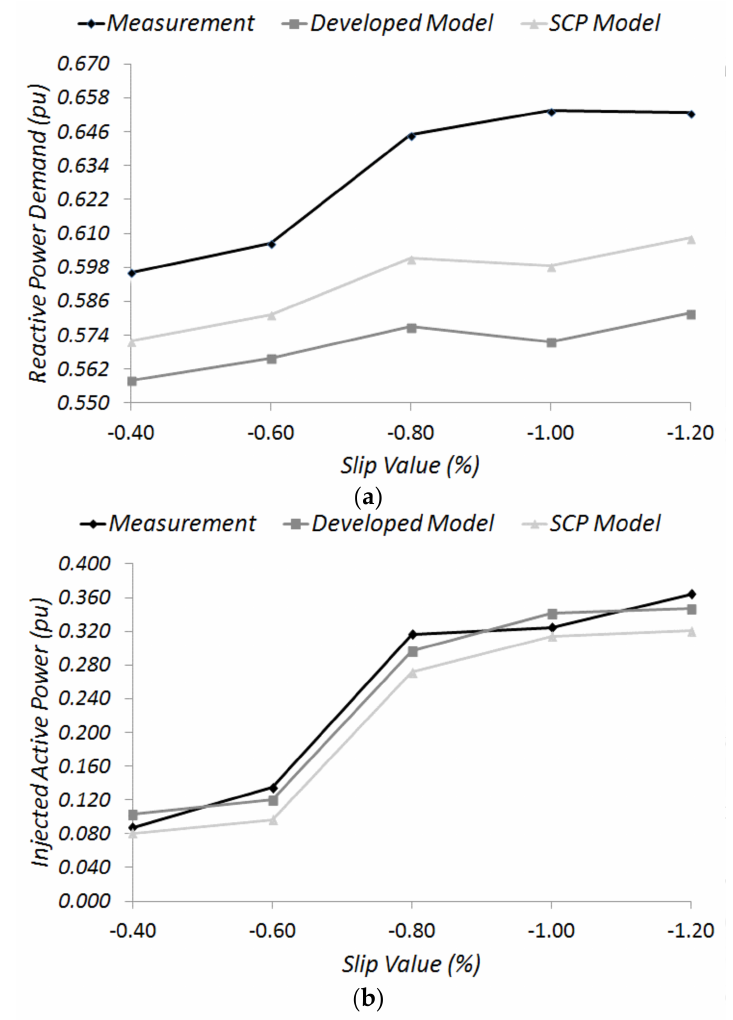
Figure 6. Variation of the reactive power demand ( a ), and injected active power ( b ) of the generator at the 5% VUF value for different rotor slip